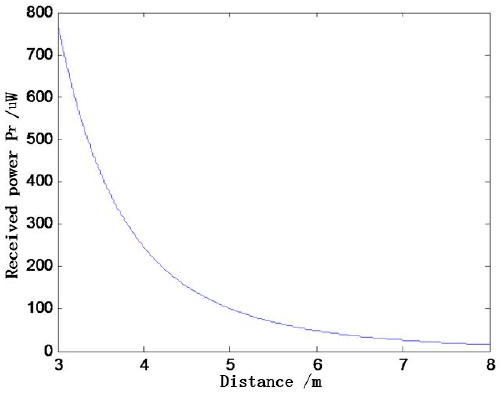
Figure 4. Relationship between received power and transmission distance.